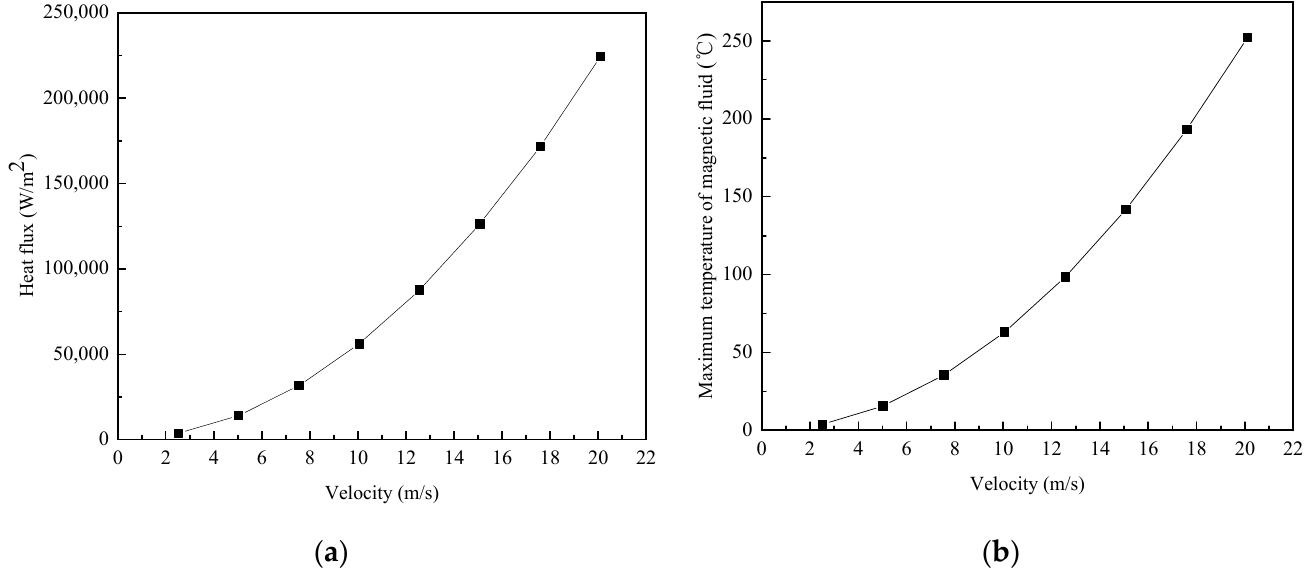
Figure 6. ( a ) Relationship between the linear velocity and heat flux; ( b ) maximum temperature of the magnetic fluid layer in the sealing gap at different linear velocities.